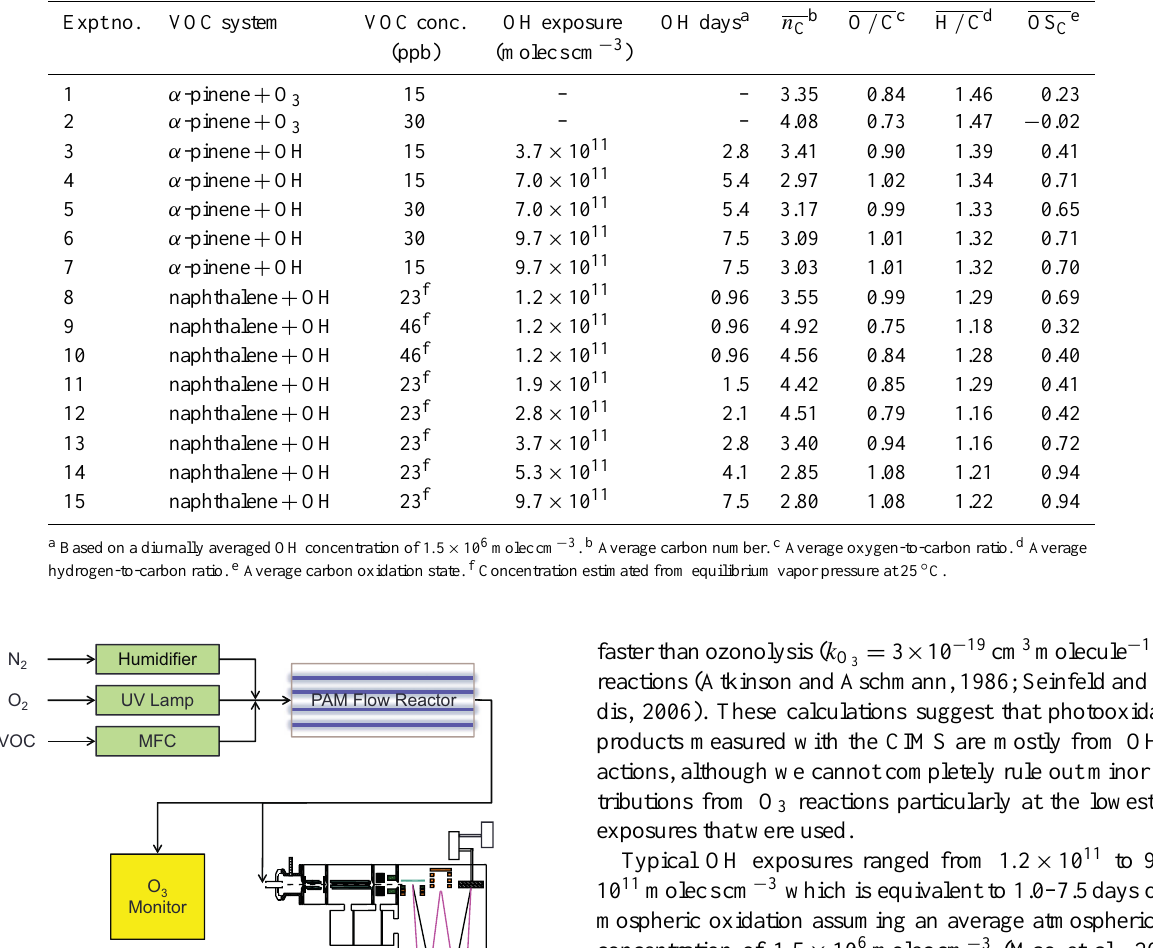
age applied to the PAM reactor lamps between 0 and 110